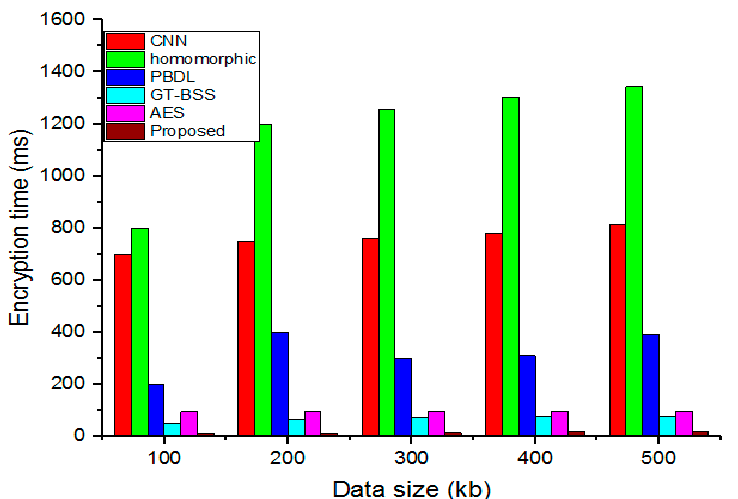
Figure 5. Analysis of variations in encryption time.